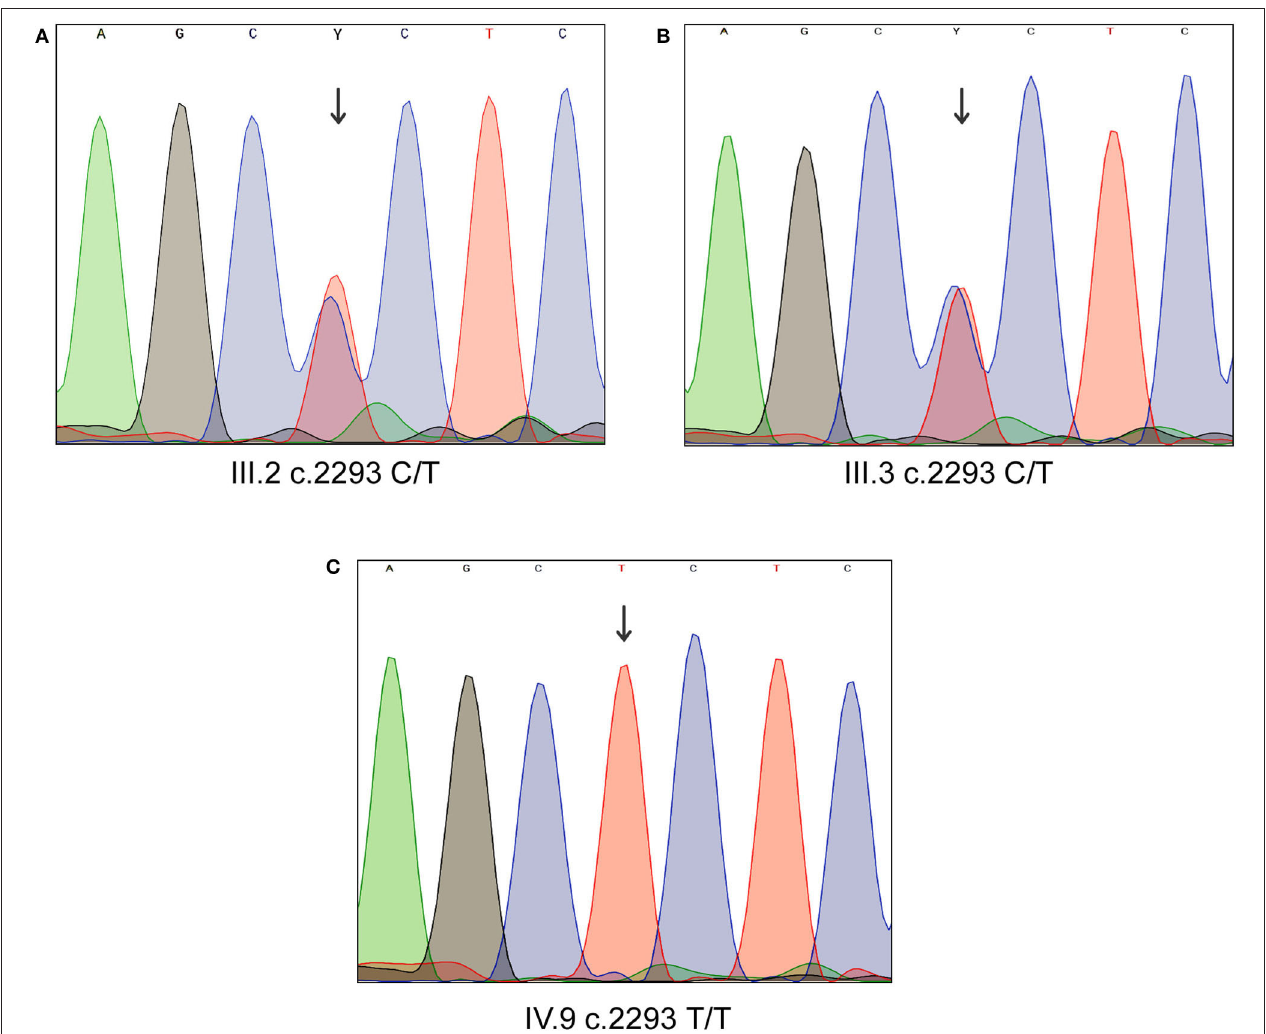
FIGURE 2 | Sanger sequencing analysis of MYO1D gene. (A) Affected proband, homozygous for the variant c.2293C > T. (B,C) Heterozygous carriers of mother and